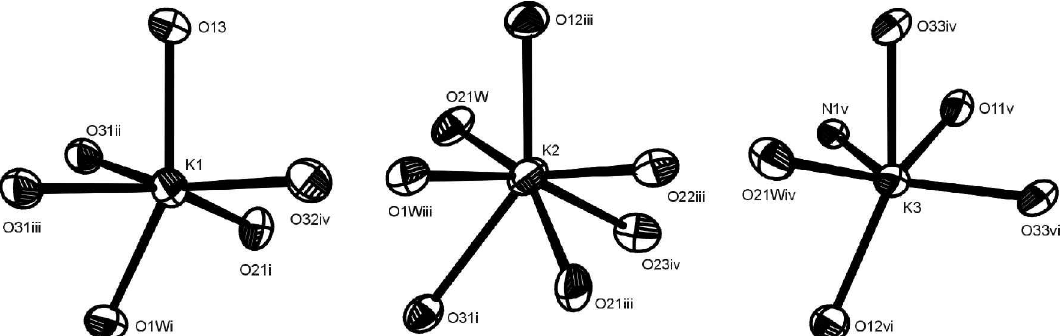
Fig. 3 The surroundings of potassium cations K1, K2 and K3 in K 3 (sac) 3 ¢ 2H 2 O. The symmetry transformations are given in Table 2. In case of K2 and K3 only the oxygen atoms of the disordered water molecules, O21W, with the largest occupancy (0.663) are shown. The thermal ellipsoids are drawn as ORTEP plots at 50 % probability